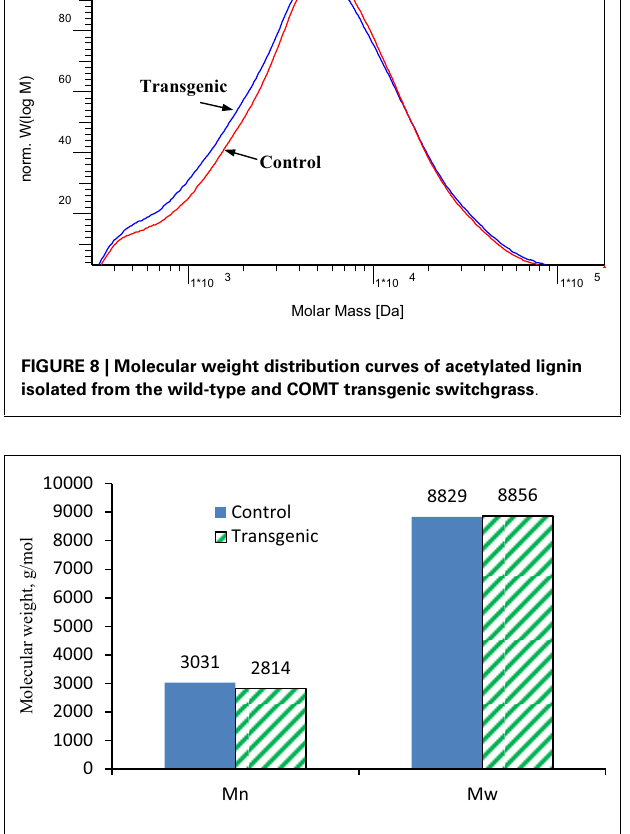
FIGURE 9 |The number-average ( M n ) and weight-average ( M w ) molecular weights of lignin isolated from the wild-type and COMT transgenic switchgrass as determined by GPC analysis